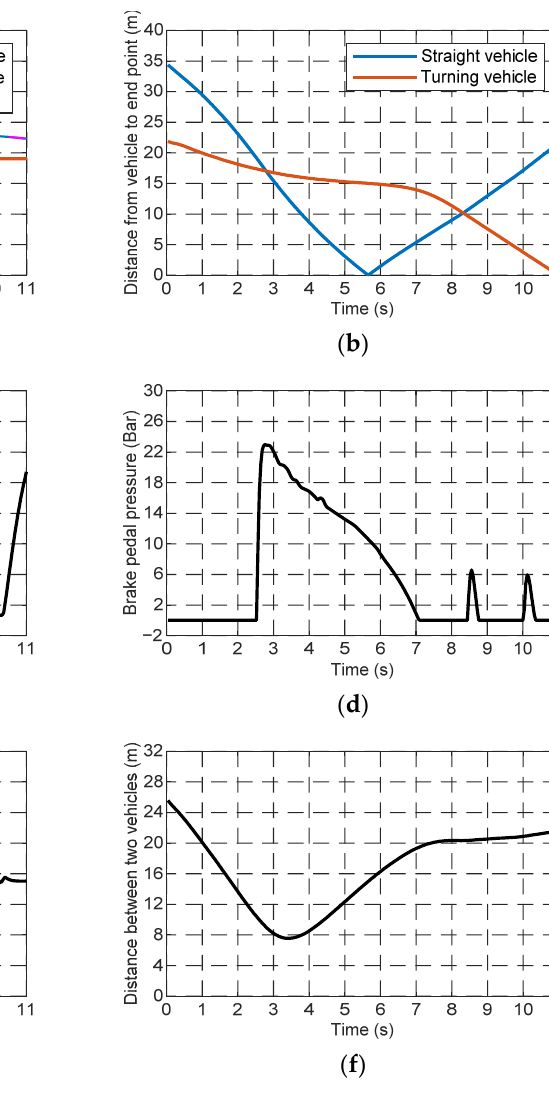
Figure 19. Simulation results of condition II: ( a ) vehicle speed, ( b ) distance to destination, ( c ) throttle percentage, ( d ) brake-pedal pressure, ( e ) vehicle acceleration, and ( f ) distance between two vehicles.